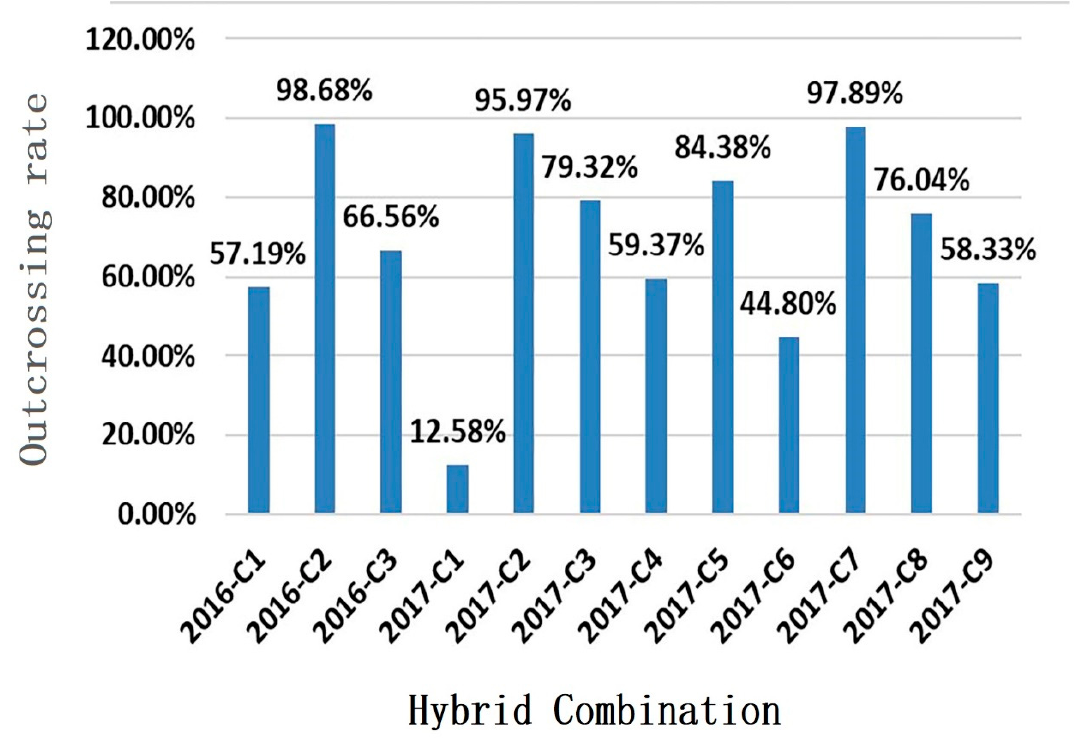
Figure 4. Outcrossing rate of each combination at 7 days after pollination in 2016 and 2017.